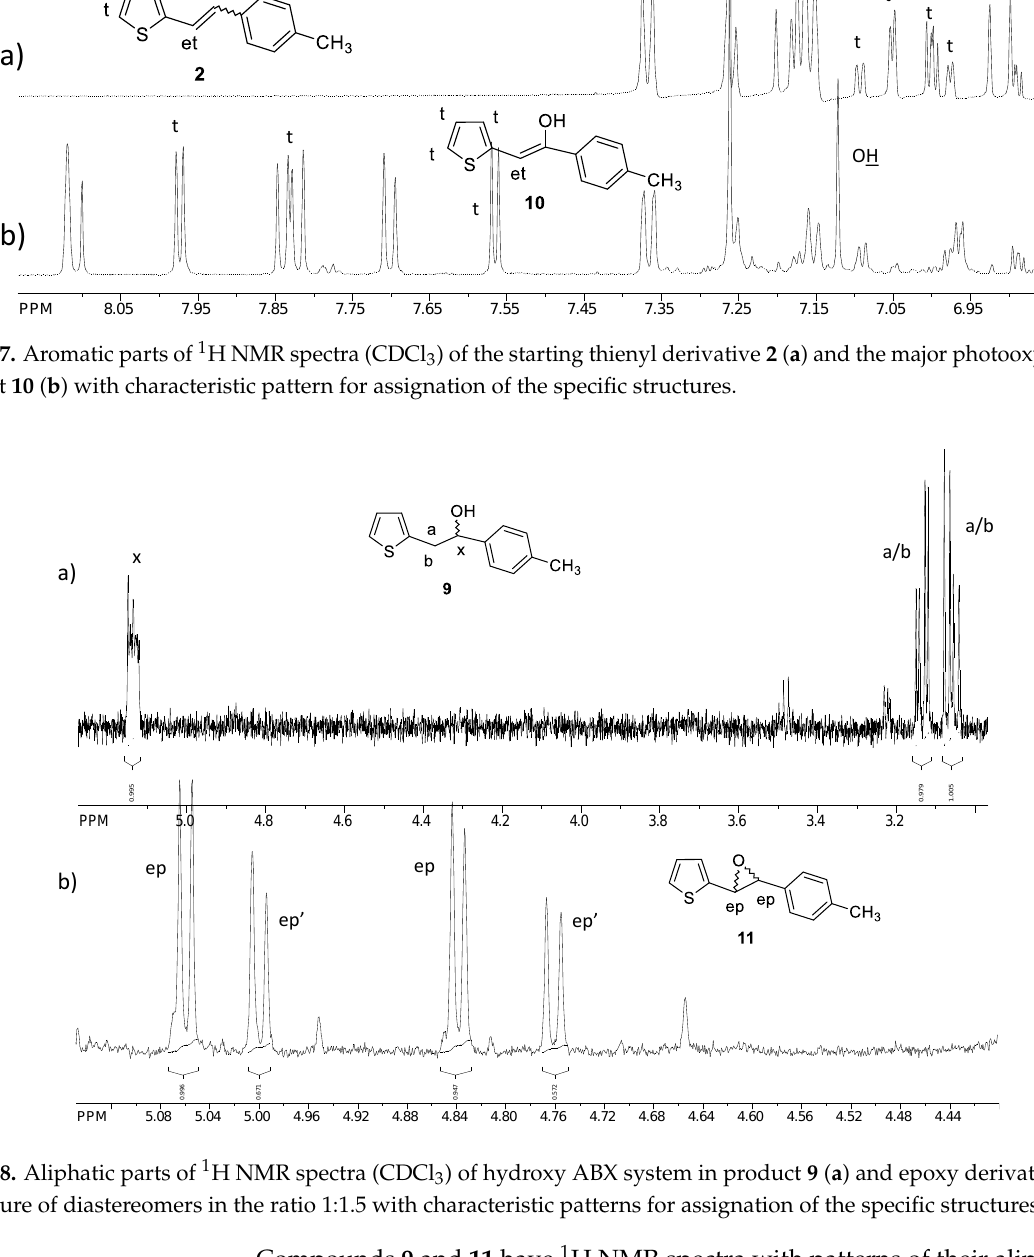
Figure 7. Aromatic parts of 1 H NMR spectra (CDCl 3 ) of the starting thienyl derivative 2 ( a ) and the major photooxygena- tion product 10 ( b ) with characteristic pattern for assignation of the specific structures.